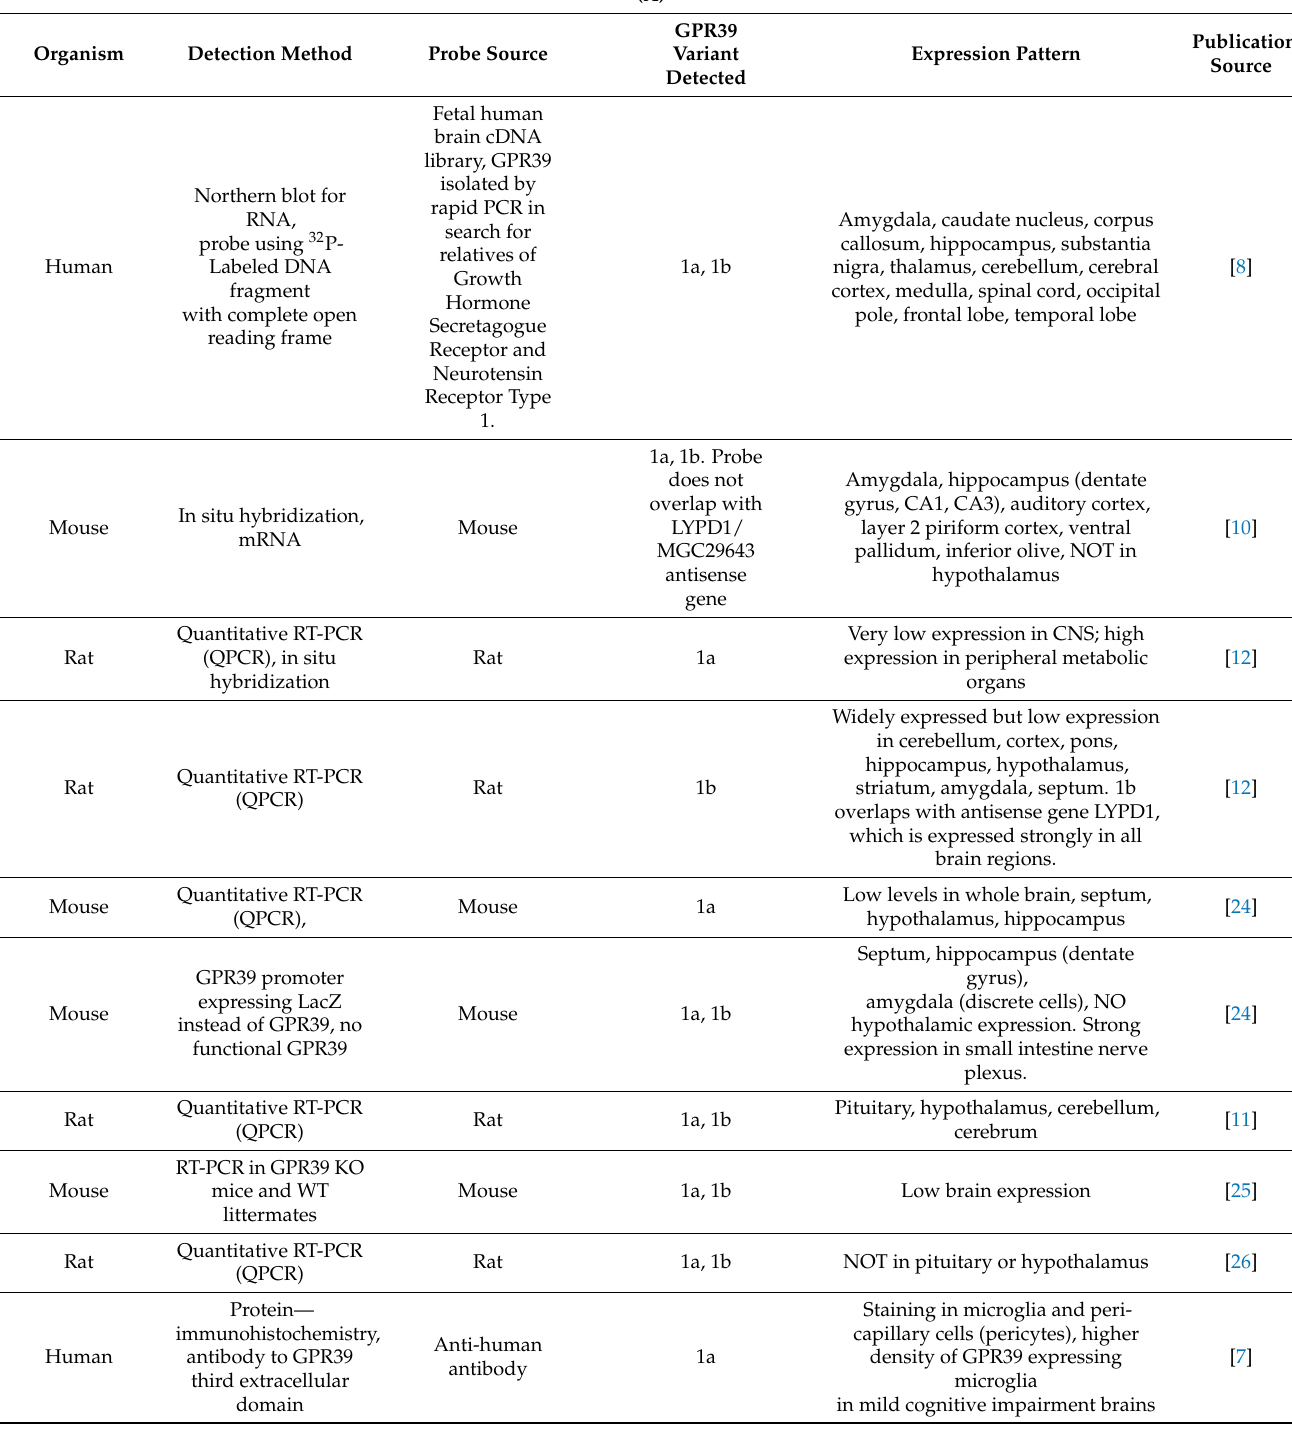
Table 1. ( A ) Expression pattern of GPR39 in published studies. GPR39 shows variable expression in published literature dependent on splice variant, species, and detection method. ( B ) In-vitro GPR39 expression and signaling cascades.GPR39 over-expression (OE) in in-vitro systems generate G-protein signaling